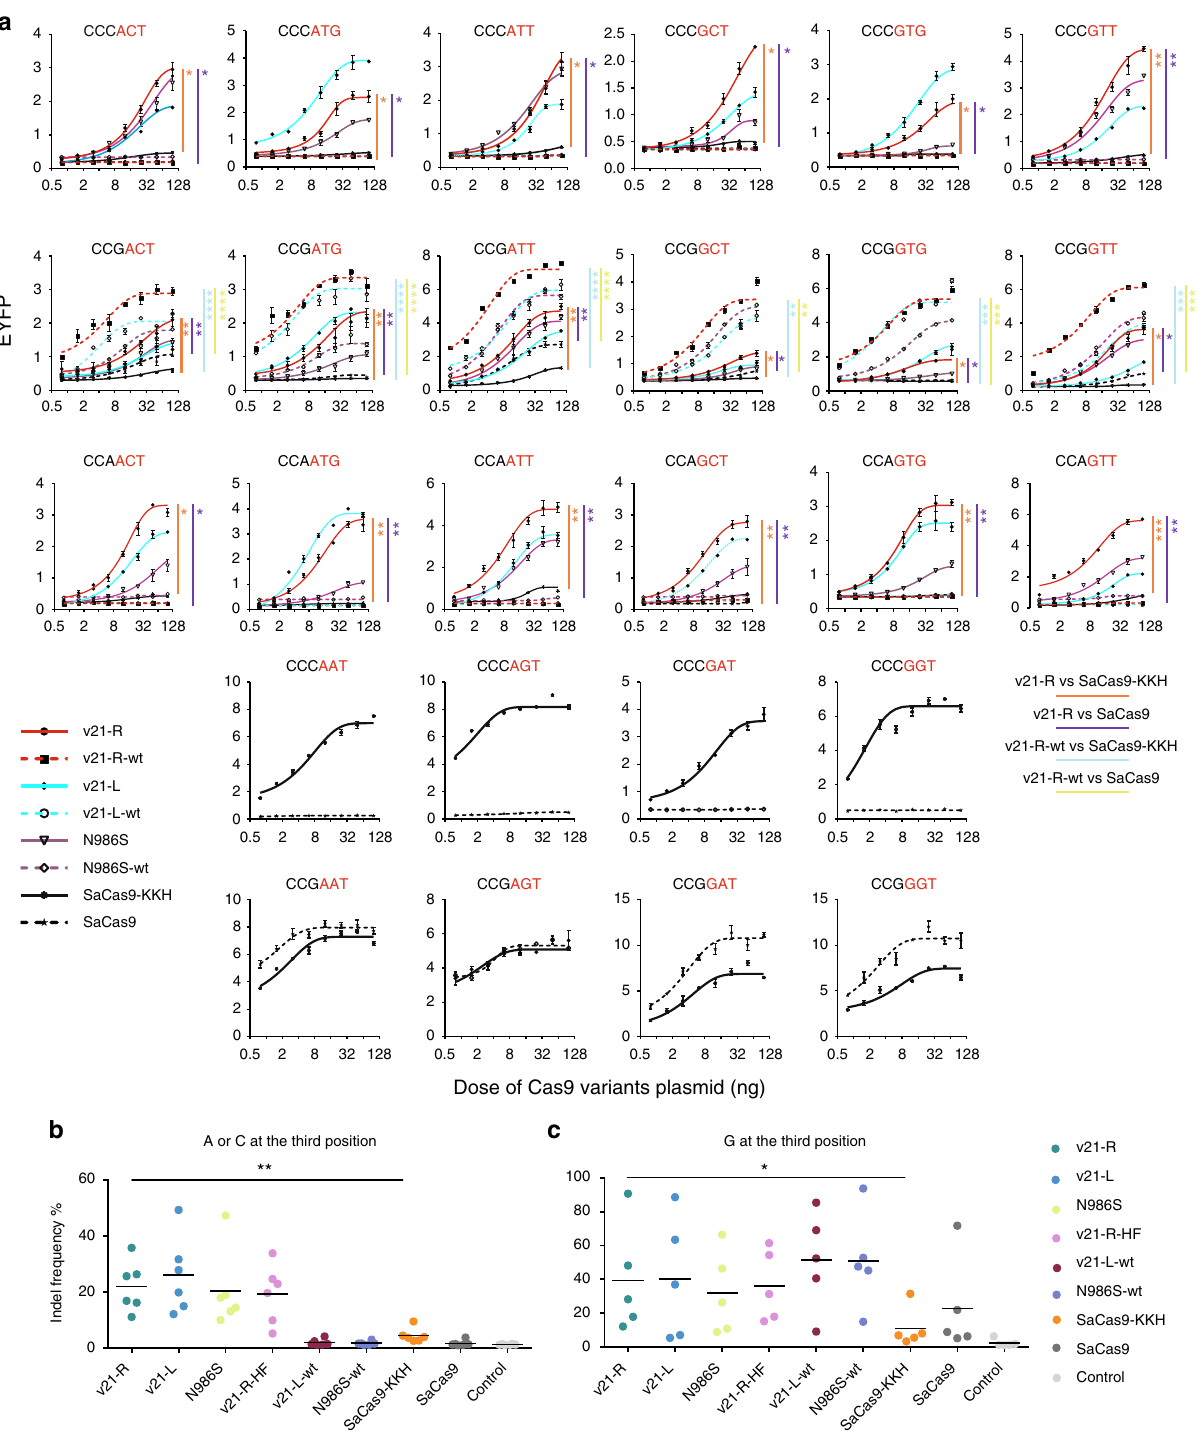
Fig. 4 Comparison of chimeric cCas9 variants at non-NNNRRN PAMs. a Direct comparison of v21-R, v21-L, N986S, v21-R-wt, v21-L-wt, N986S-wt, SaCas9, and SaCas9-KKH with eight plasmids doses across CCVACT, CCVGTG, CCVGTT, CCVGCT, CCVATT, CCVATG PAMs (V = A, C or G) by EYFP reconstitution assay. ( n = 3) Error bars, s.e.m. The relative EYFP fl uorescence intensity ( y -axis) is measured by FACS. b Indel frequency induced by indicated variant at the sites where the third position of PAM is A or C. c Indel frequency induced by indicated variant at the sites where the third position of PAM is G. Each point represents the mean of one endogenous site ( n = 3 independent biological replicates). The black line indicates the mean activities at all targets. a , b and c * P < 0.05 (paired t -test, two-tailed); ** P < 0.01 (paired t -test, two-tailed); *** P < 0.001 (paired t -test, two-tailed); **** P < 0.0001 (paired t -test, two-tailed). Source data are provided as a Source Data fi